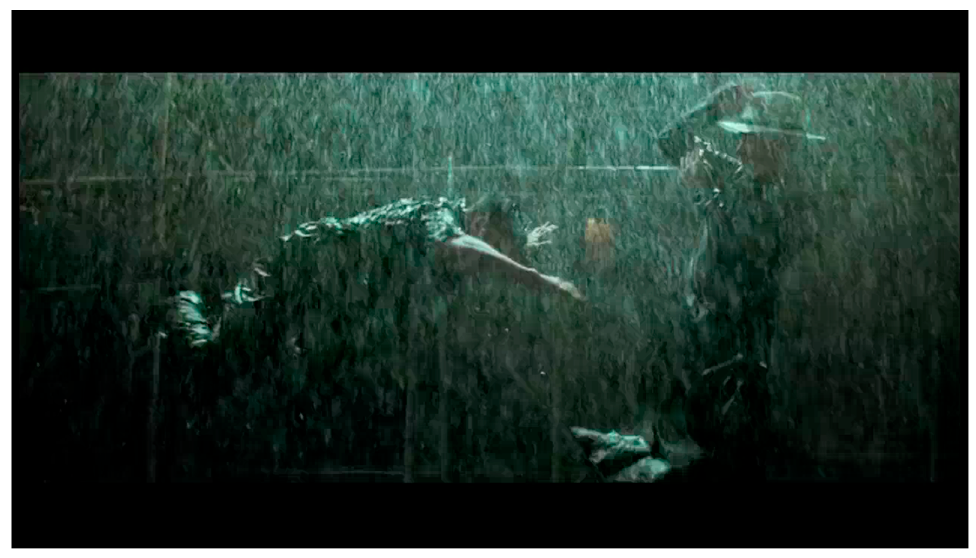
Figure 15. Obscured behind torrents of driving water. Frame capture, The Grandmaster (Wong 2013).